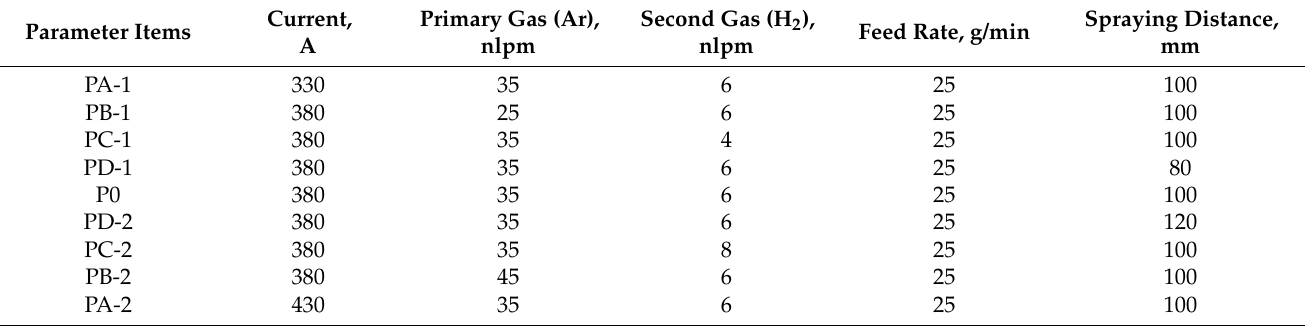
Table 1. Summary of the operating deposition